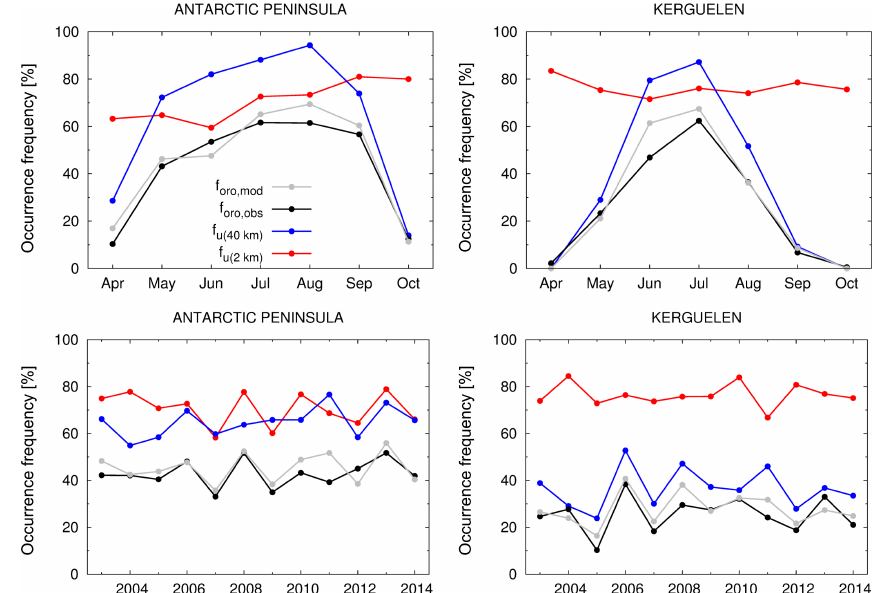
Figure 9. Monthly (top) and yearly (bottom) variability of orographic wave activity during April–October in 2003–2014 at the Antarctic Peninsula and Kerguelen Islands. Time series show occurrence frequencies of orographic waves from AIRS observations (black) and the mountain wave prediction model (gray). Also shown are occurrence frequencies of the zonal winds at the 2km (red) and 40km (blue) levels exceeding the prediction model